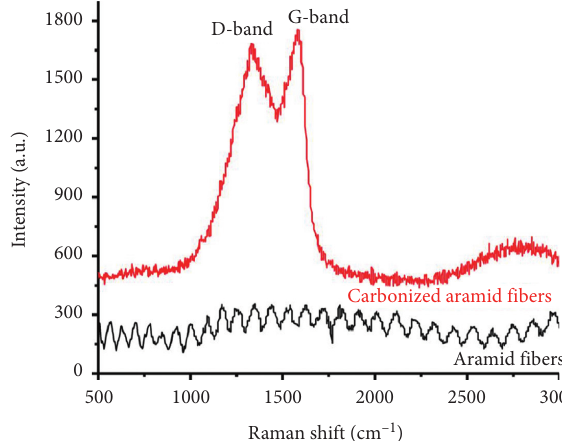
Figure 4: Raman spectra of aramid fiber and carbonized aramid fiber.